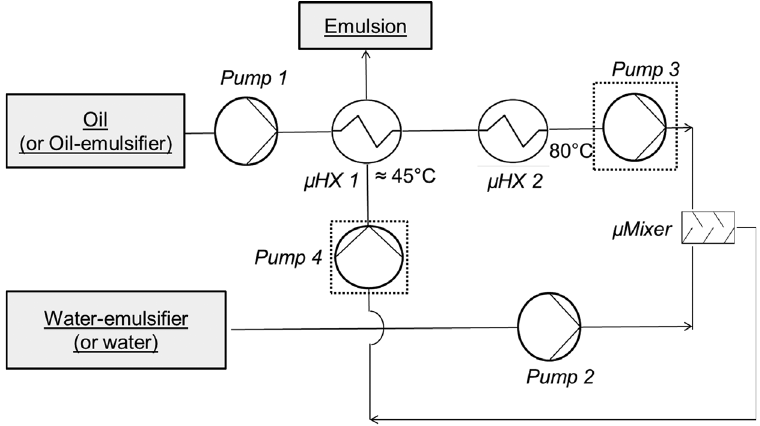
Figure 5 Flow diagram for continuous emulsification process using microstructured devices and energy recuperation.